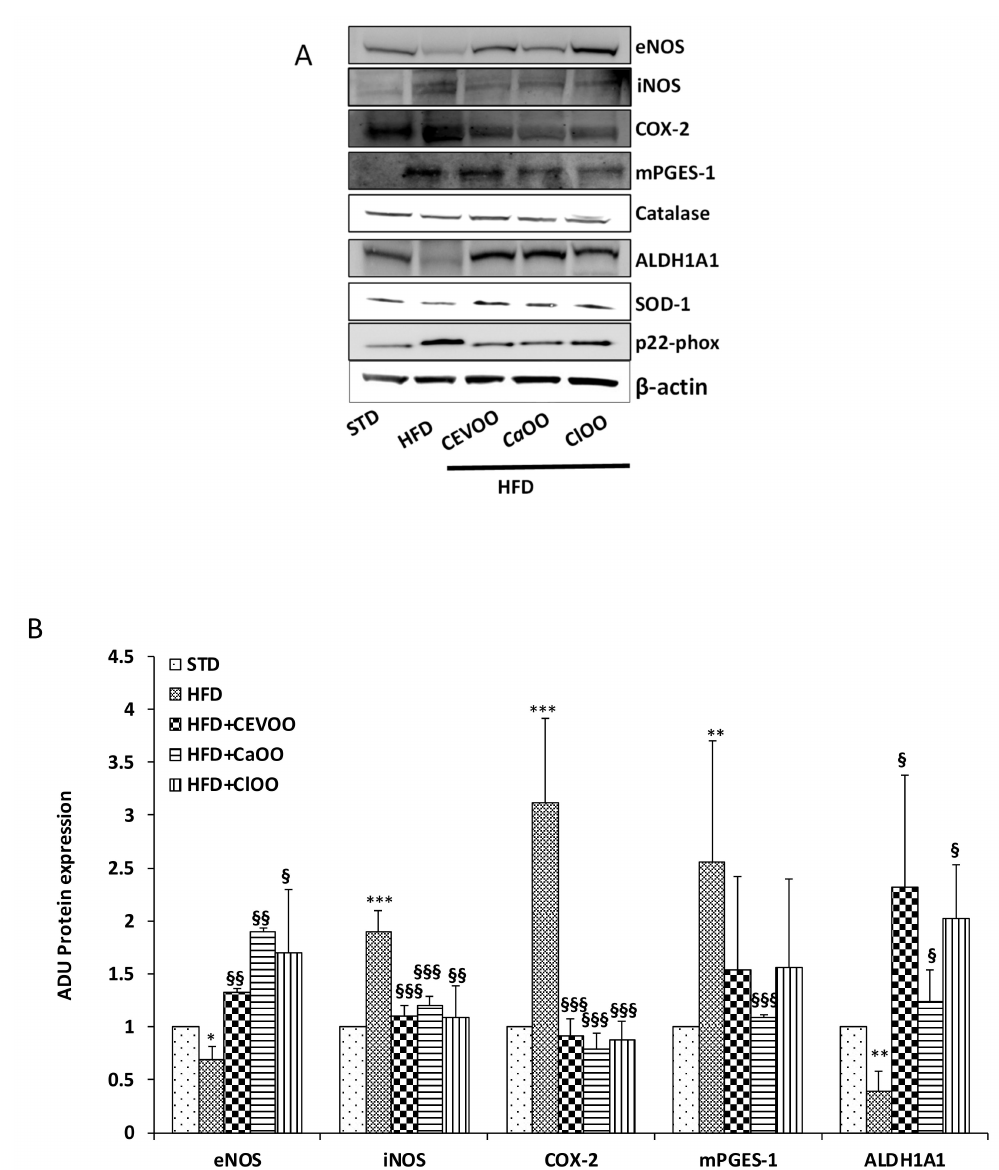
Figure 7. E ff ects of CEVOO, Ca OO and Cl OO diet supplementation on homeostatic, inflammatory and oxidant factors in aortic vessel tissues of HFD fed rats. ( A ) Western blot analysis of homeostatic factors (eNOS, ALDH1A1), inflammatory factors (iNOS, COX-2 mPGES-1) and oxidant factors (Catalase, SOD-1 and p22phox) in aortic vessel tissues. Each line contains 50 µ g of total proteins obtained from aortic vessels of rats treated as designated. ( B ) Quantification of western blots. Data are reported as a ratio of arbitrary density unit (ADU) target protein / β -actin and are means ± standard deviation ( n = 3); Data are reported as fold change vs. STD which was assigned to 1. * p < 0.05, ** p < 0.01, *** p < 0.001 vs. STD; § p < 0.05, §§ p < 0.01, §§§ p < 0.001 vs.